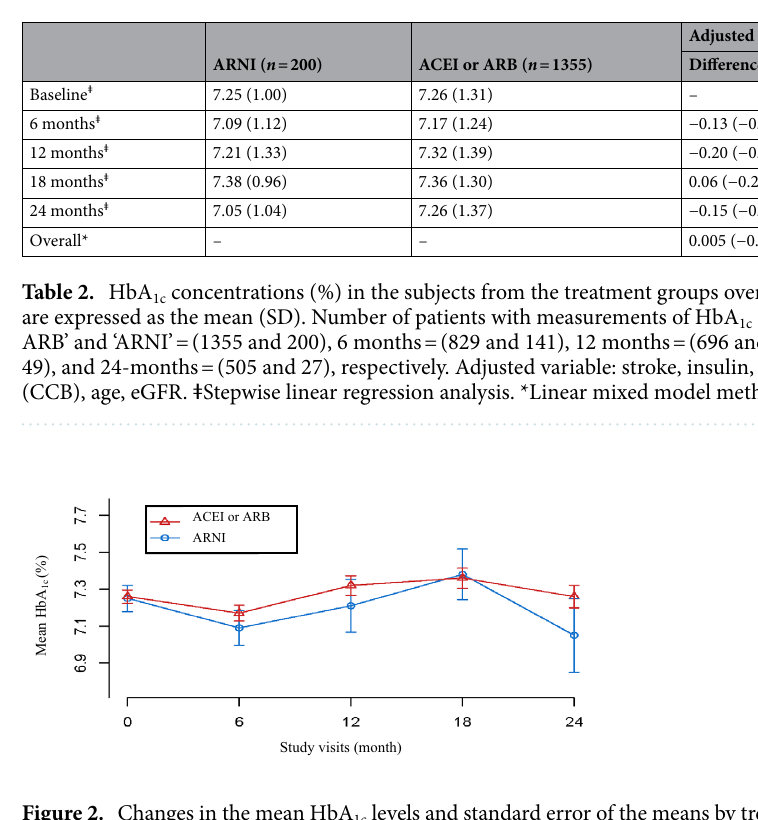
Figure 2. Changes in the mean HbA 1c levels and standard error of the means by treatment group at the baseline, 6-month, 12-month, 18-month, and 24-month visits.